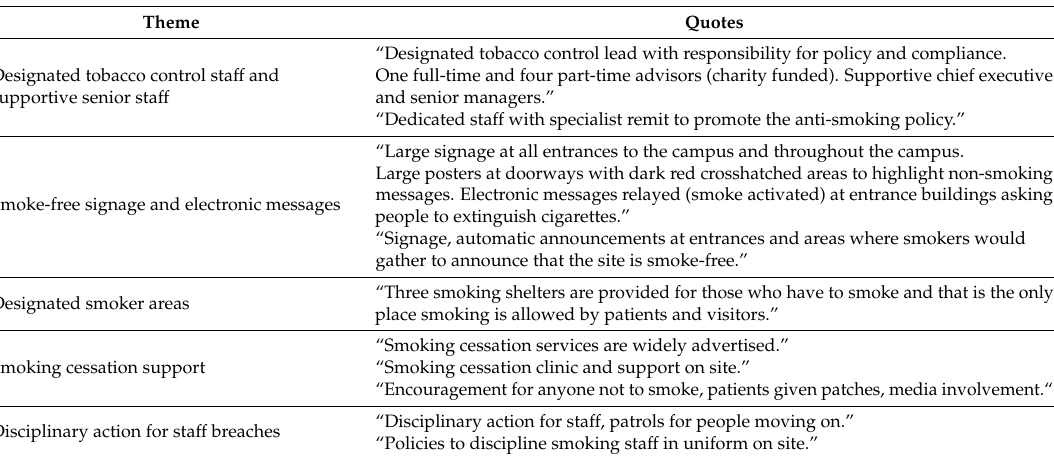
Table 2. Enablers to achieve the smoke-free policy in practice.